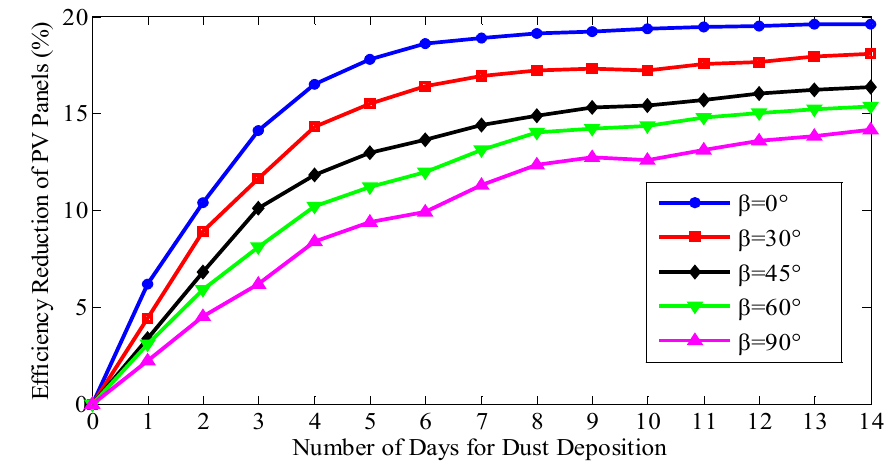
Figure 10. Sample set for PV panels with tilt angle β = 0 ◦ .